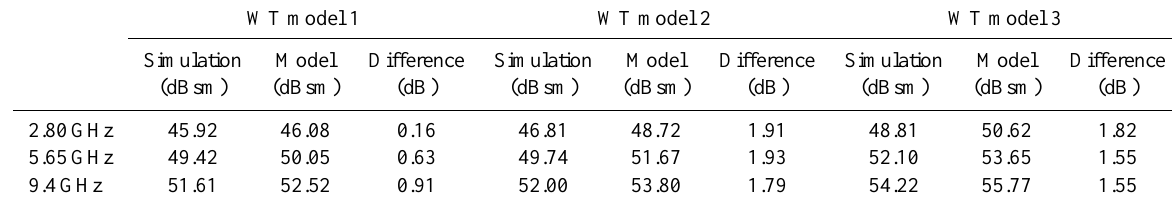
Table 4. Comparison of the maximum RCS of the blades from PO simulations and the maximum RCS values calculated according to the proposed model. The third column shows the difference in dB between the values obtained in the simulations and the values calculated according to the proposed